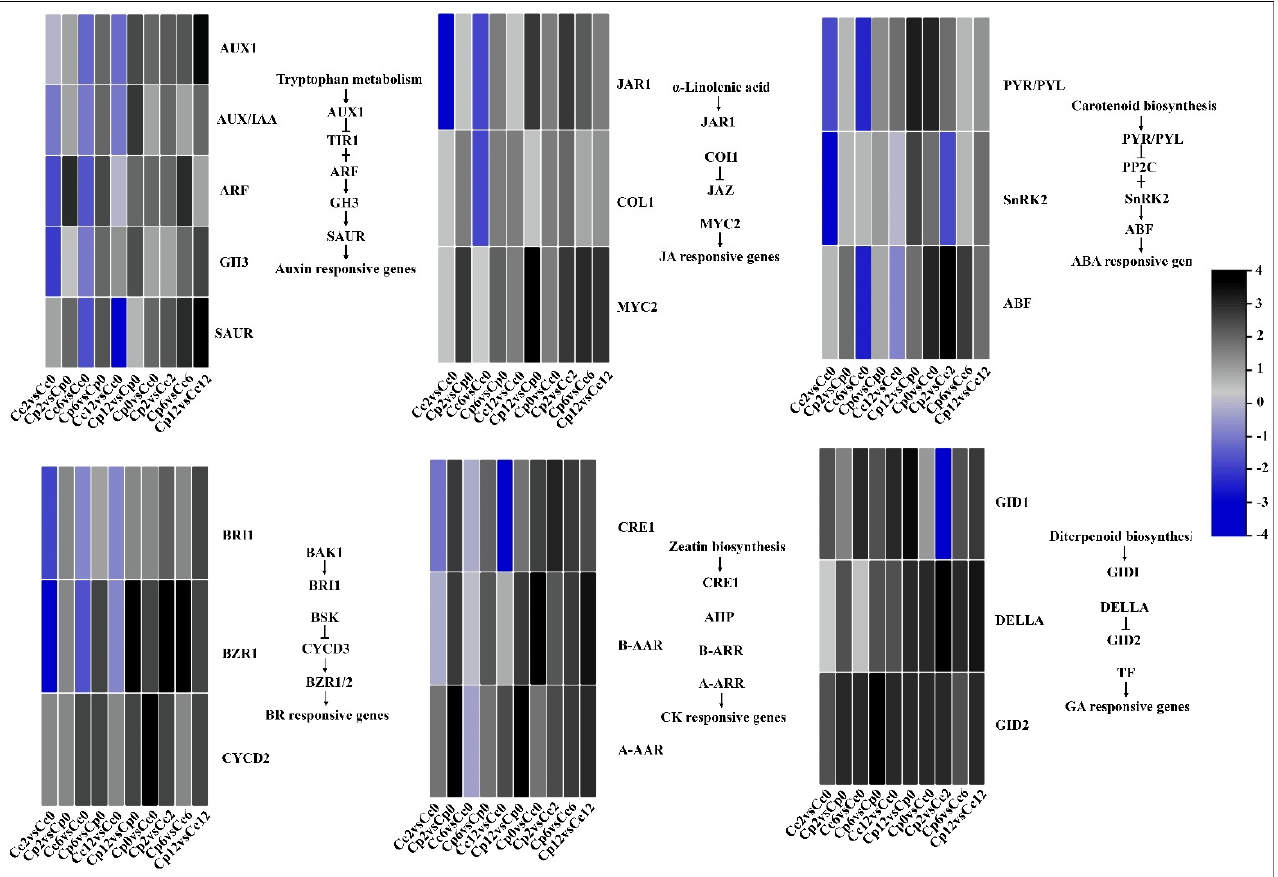
Figure 7. Differentially expressed hormone signaling pathway genes in the cold-treated C. pubescens and C. chinense pepper